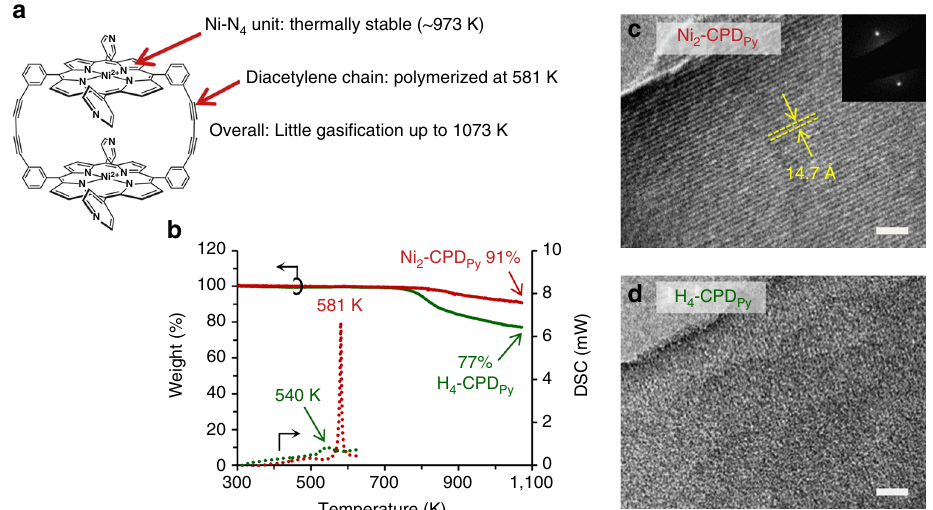
Fig. 1 Structure of Ni 2 -CPD Py and its thermal properties up to a temperature of 1073 K. a Structure of Ni 2 -CPD Py and its superior properties as a precursor of carbonization. b TG ( solid lines ) and DSC curves ( dotted lines ) of Ni 2 -CPD Py ( red ) and H 4 -CPD Py ( green ). Yields at 1073 K are described for TG curves, while peak temperatures are shown for DSC curves. c , d TEM images of the residues of ( c ) Ni 2 -CPD Py and ( d ) H 4 -CPD Py after TG measurements. Scale bars = 10 nm. Inset: a selected-area diffraction pattern for